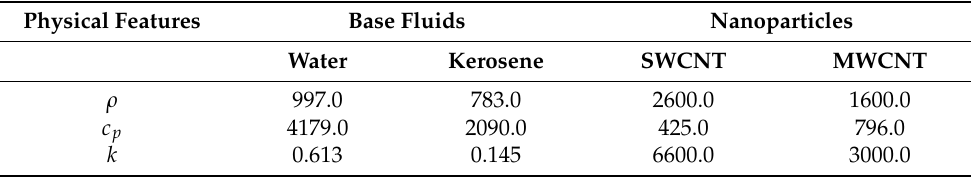
Table 1. Thermophysical features of base fluid and nanoparticles (SWCNT and MWCNT) [41].